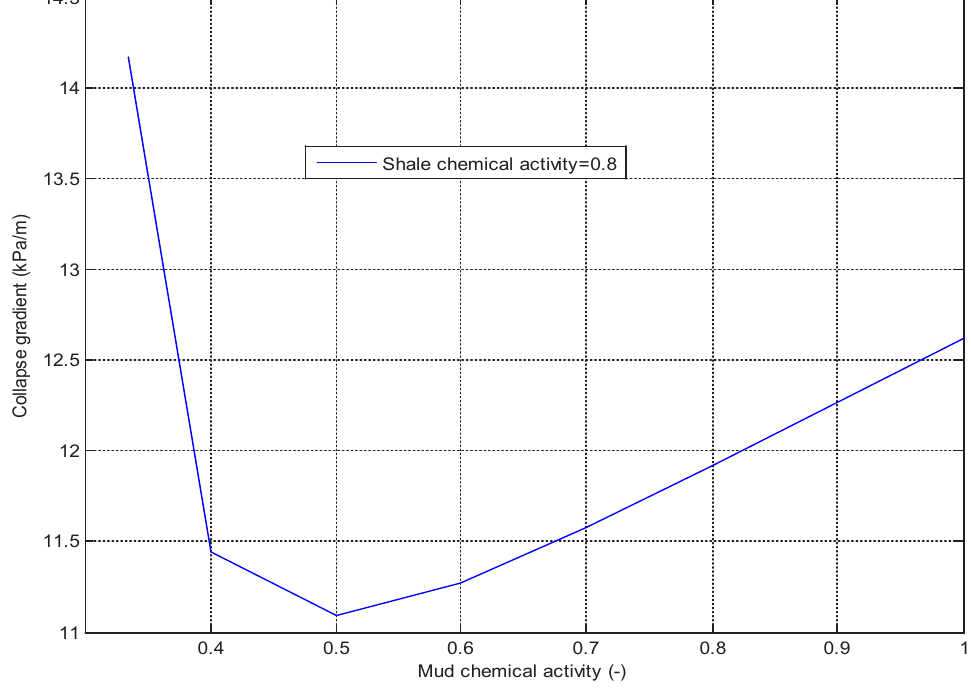
Figure 3: Effect of mud chemical activity on the critical mud